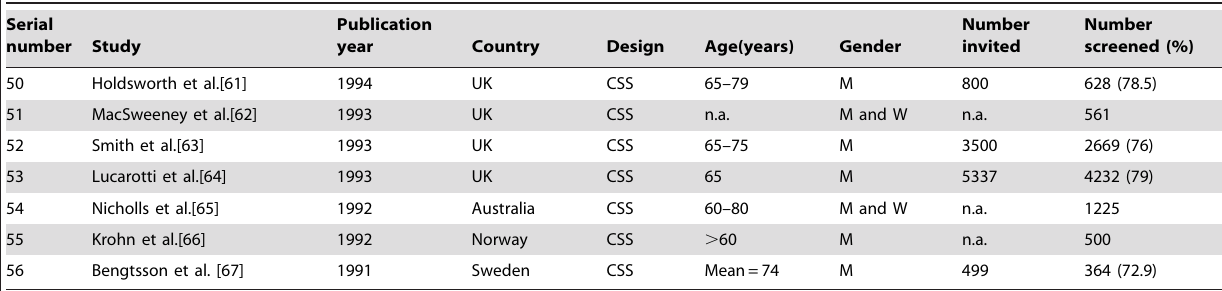
Abbreviation: AAA, asymptomatic abdominal aneurysm; CSS, Cross-sectional study; RCT, Randomized controlled trial; PCS, Prospective cohort study; W, Women; M, Men; 95% CI, 95% confidence interval; n.a., not applicable; n.r., no data or no data in appropriate format